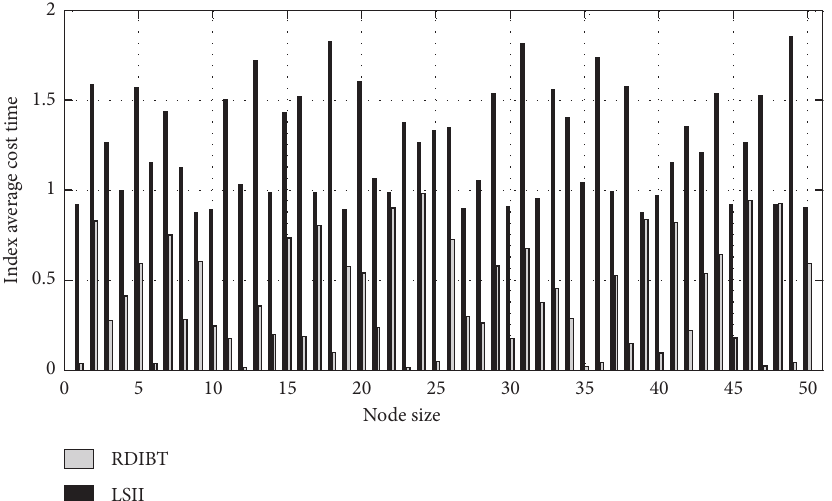
Figure 10: The average cost time of the index under the change of node size.